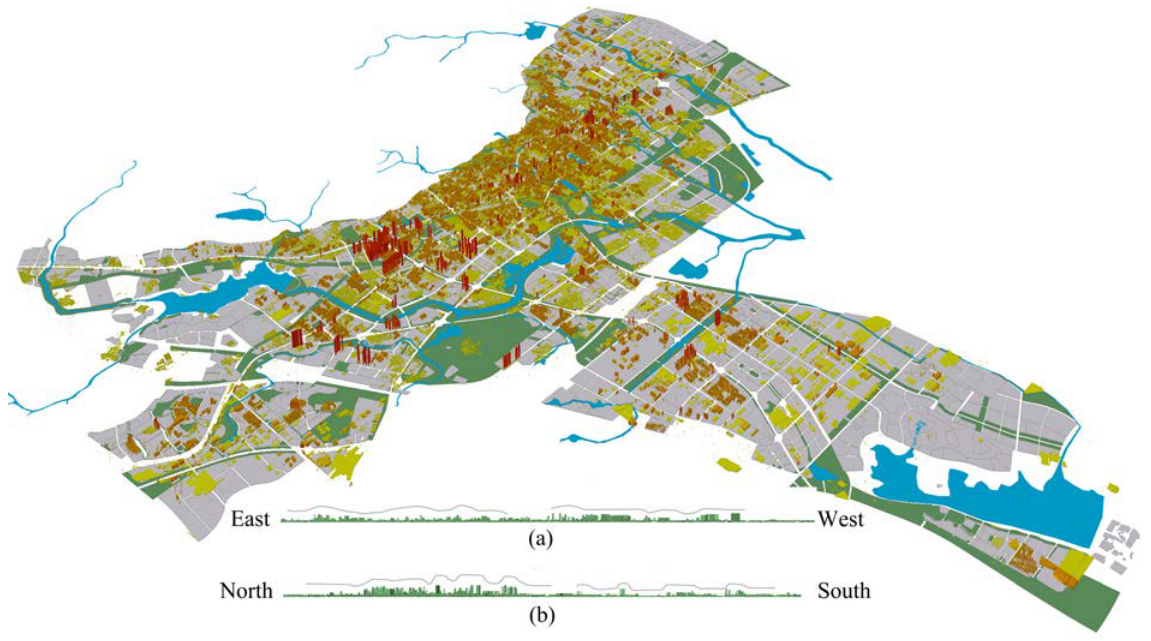
Figure 6. Skyline analysis (a. The north of skyline, b. The south of